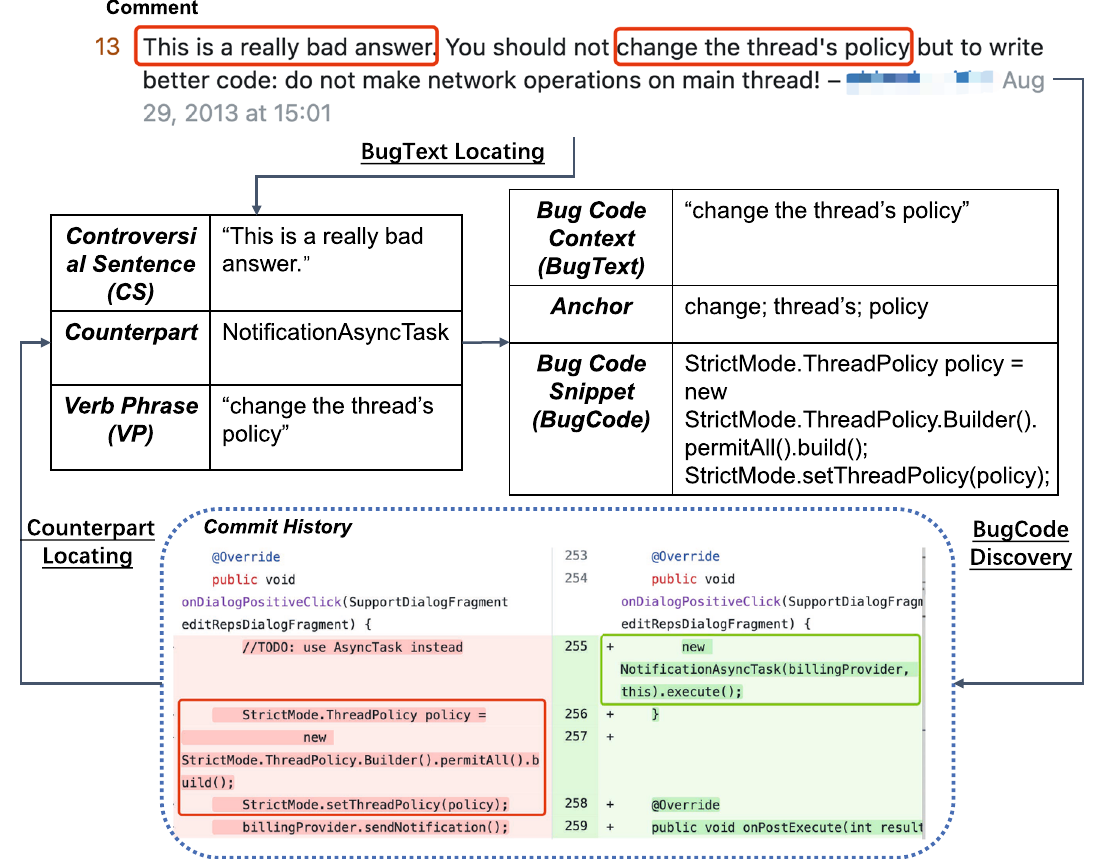
Fig. 3 The example of knowledge extracted from StackOverflow